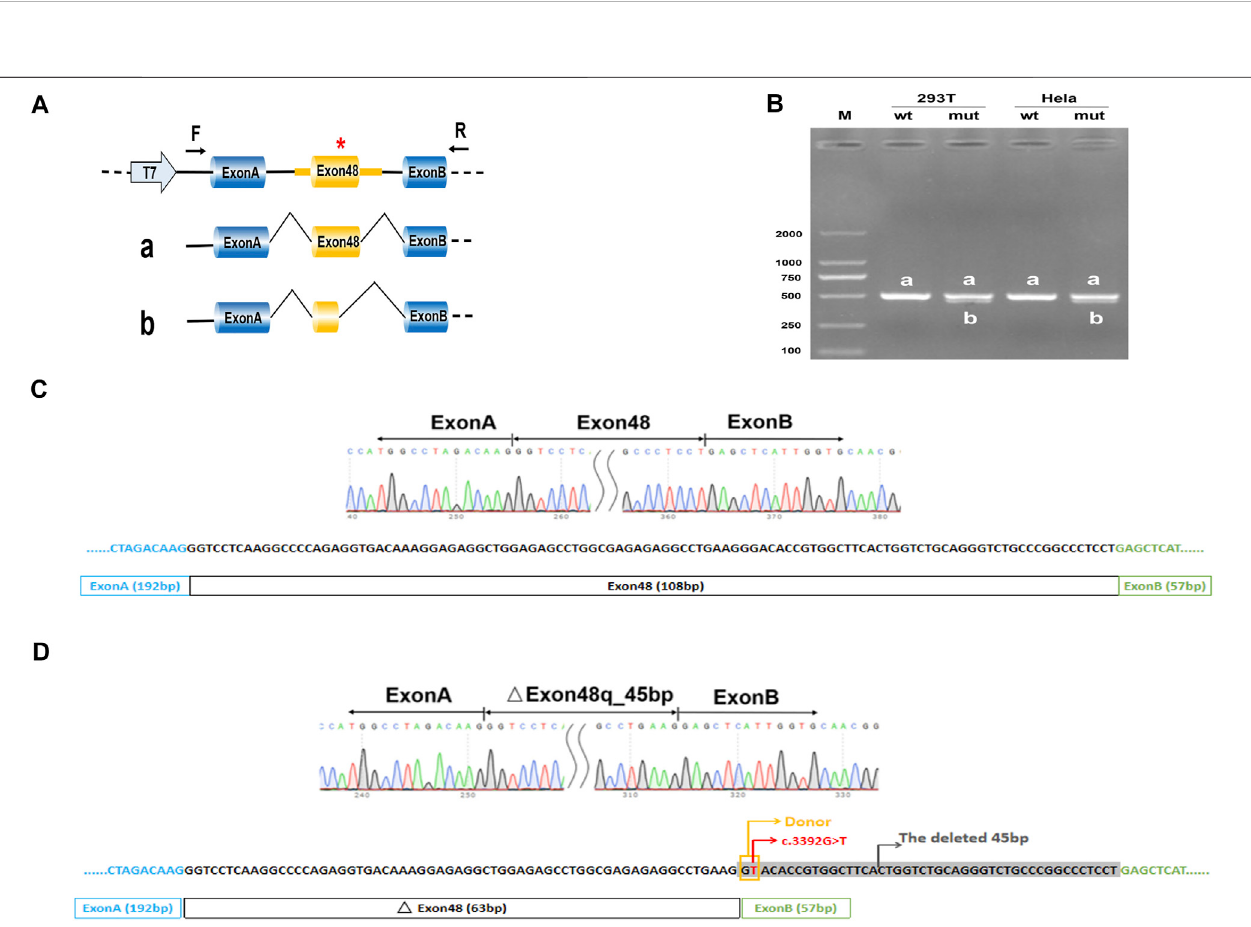
FIGURE 2 | Minigene analysis based on pcDNA3.1-COL2A1-wt/mut recombinant vectors. (A) , Schematic illustration of cloned vectors. Red * indicates the mutation position. (B) Gel electrophoresis of the RT-PCR products in both 293T and HeLa cell lines. M means the DNA marker. Wild type (wt) exhibited a single band, a (full); mutant type (mut) exhibited double bands, a (full) and b (45 bp deletion). (C) Sanger sequencing result of the normal transcript. (D) Sanger sequencing result of the transcript with cryptic splicing caused by the mutation. The two bases in the yellow rectangle form a new donor, and the sequences in grey shade represent the missing 45